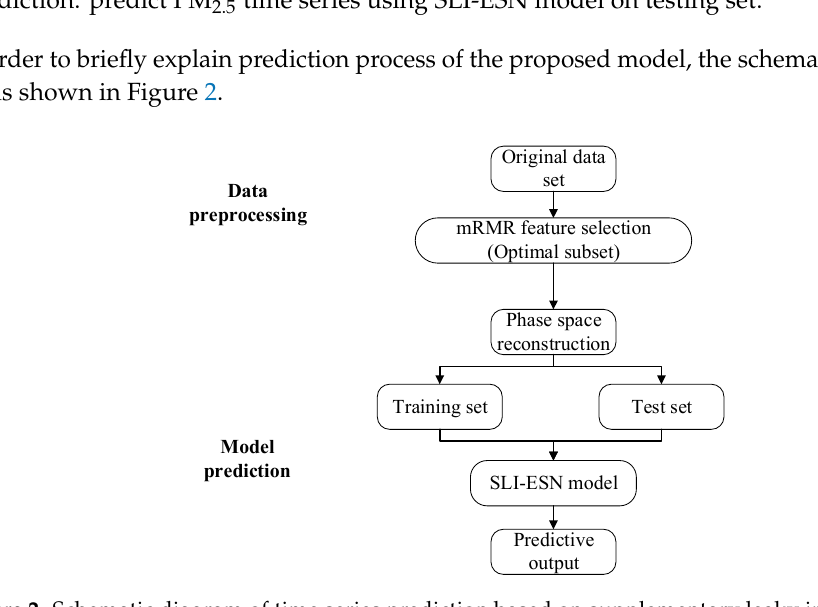
Figure 2. Schematic diagram of time series prediction based on supplementary leaky integrator echo state network (SLI-ESN). mRMR: minimum redundancy maximum relevance.